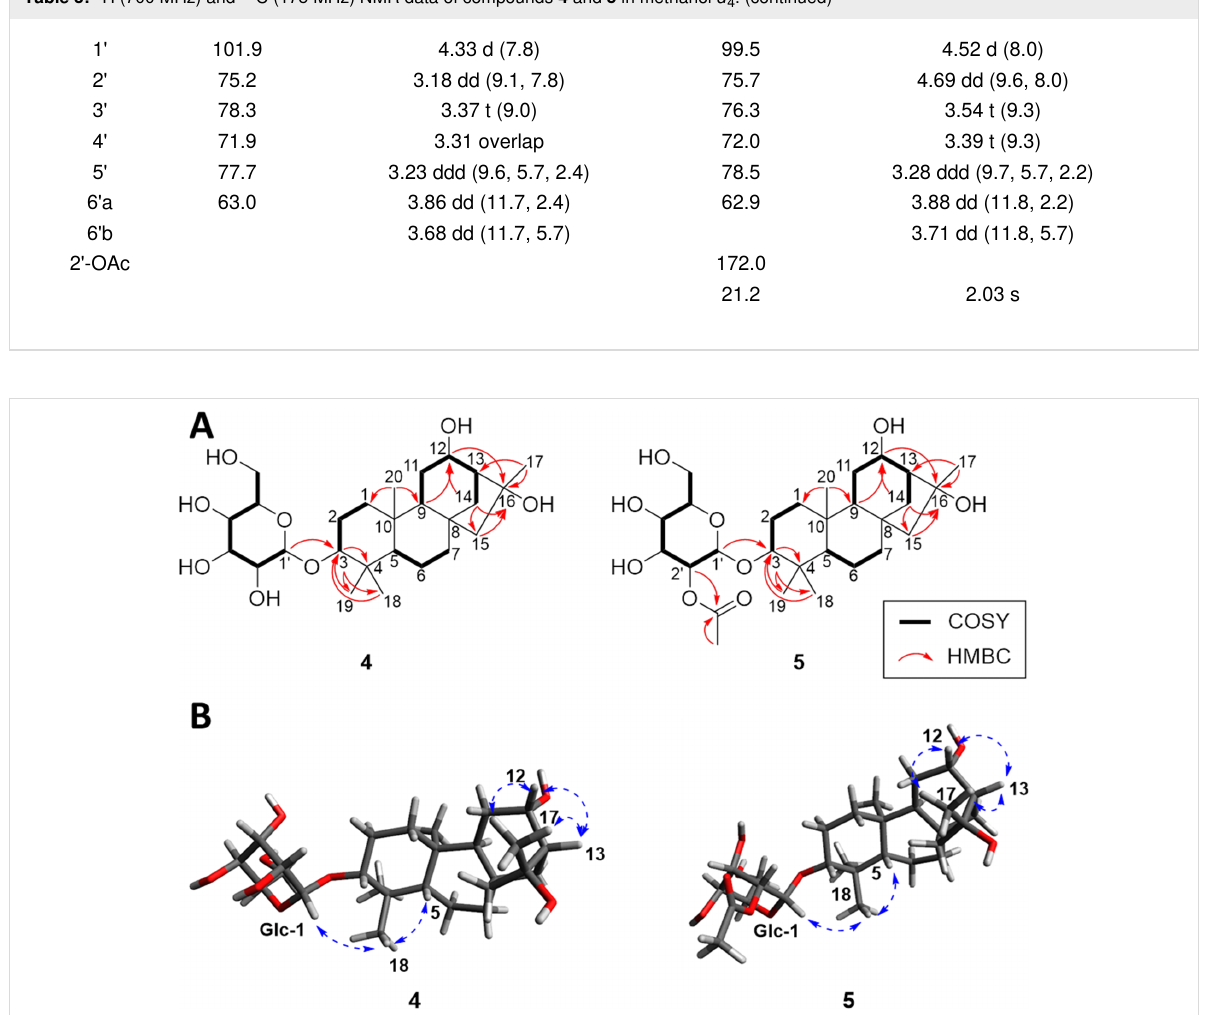
Table 3: 1 H (700 MHz) and 13 C (175 MHz) NMR data of compounds 4 and 5 in methanol- d 4 . (continued)